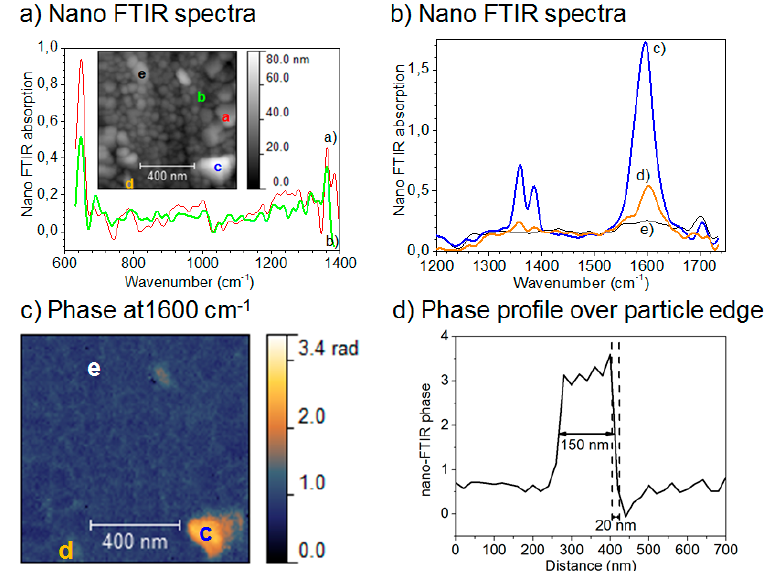
Figure 9. (a) Nano Fourier transform infrared spectroscopy (FTIR) spectra showing the presence of Cu 2 O at 650 cm − 1 with an inset displaying an AFM topography map; ( b ) IR spectra a point ( c – e ) in figure ( a , c ) an IR phase image at 1600 cm − 1 where the phase is related to the IR absorption; and ( d ) an IR profile over a particle showing a spatial resolution of 20 nm. Reprinted from reference [74] with permission from Elsevier. Copyright 2016.